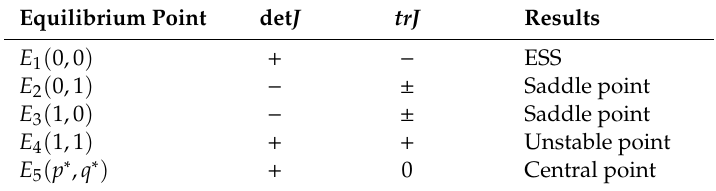
Table 7. The evolutionary stability of local equilibrium points in Case 4. Equilibrium Point det J trJ Results